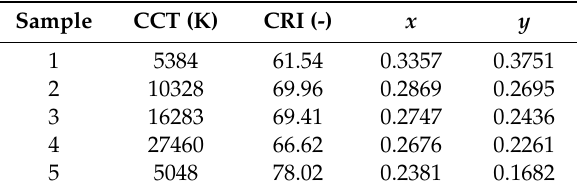
Figure 12. Measured CRI ( a ) and CCT ( b ) values for samples 1–5 with excitation using the LD PL450B. Table 5. CCT, CRI and color coordinates for samples 1–5.